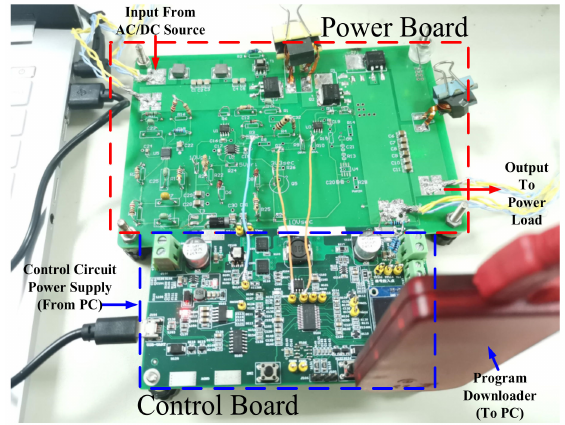
Figure 9. The prototype and environment.